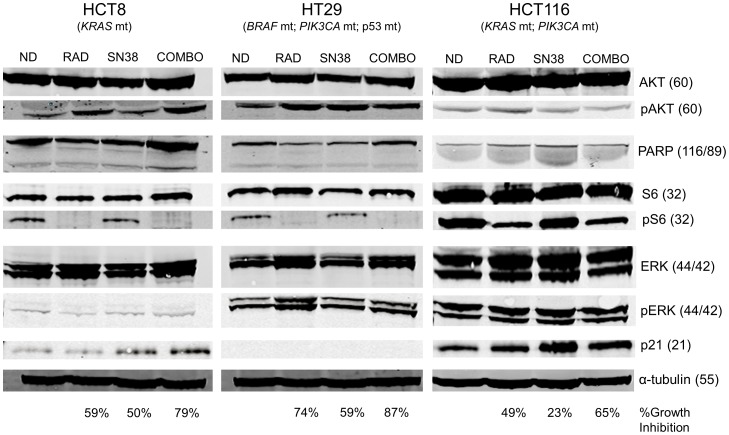
Western blot analysis of everolimus and SN38 treatment effects in HCT8, HT29 and HCT116 cells.Akt, p-Akt, PARP, cleaved PARP, total ribosomal S6 kinase (S6), ribosomal phospho-S6 kinase (pS6), ERK, p-ERK, p21 and α-tubulin were measured in all lines following 24 hours of treatment with RAD (20 nM), SN38 (4 nM) or the combination of the two. Molecular weights are presented next to protein name in parenthesis. Note that SN38 is used in in vitro assays instead of irinotecan since it is the active metabolite.